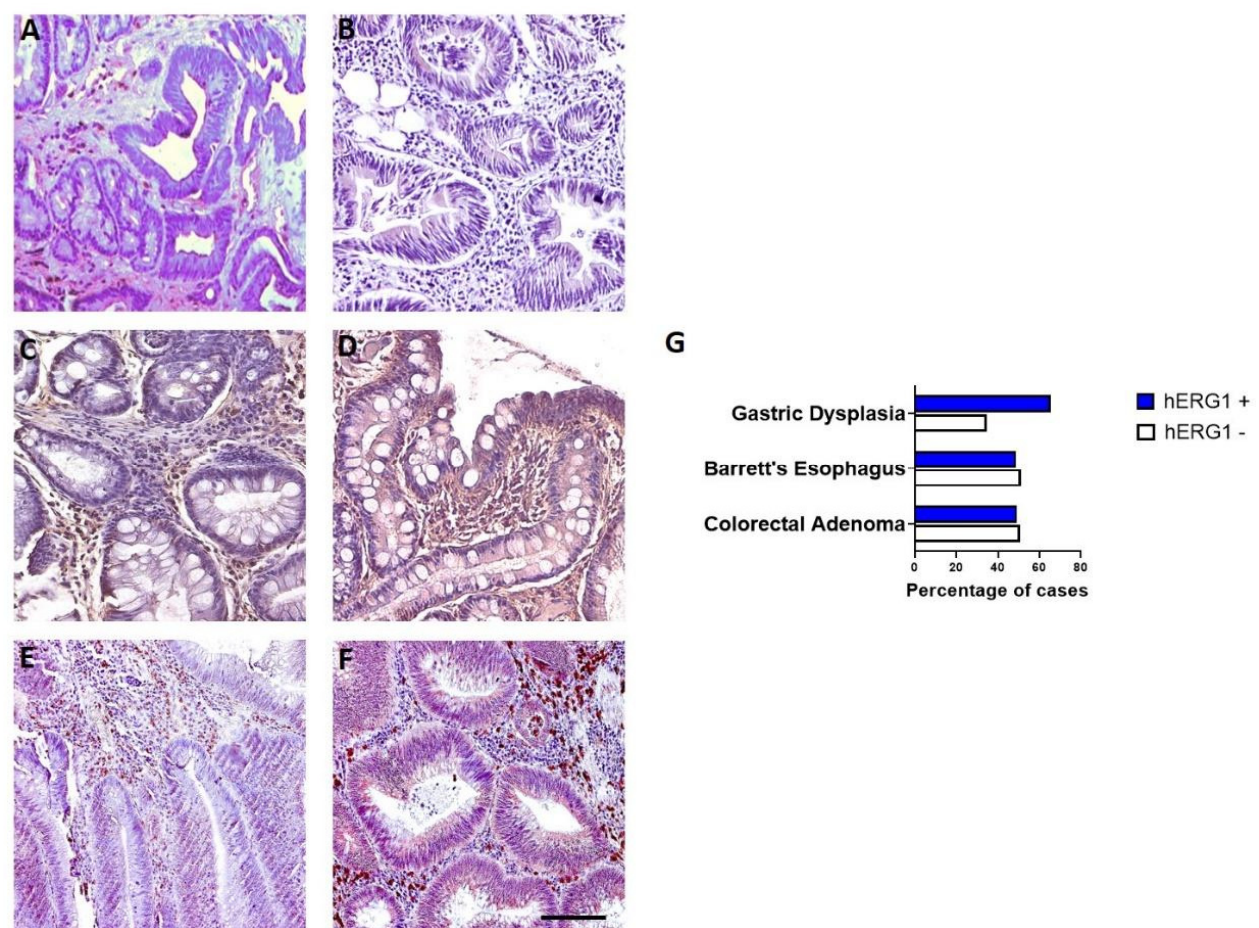
Figure 2. hERG1 potassium channel expression in preneoplastic lesions of the GI tract. ( A , B ) Gastric dysplasia. ( C , D ) Barrett’s esophagus. ( E , F ) colorectal adenoma. Scale bar:100 μ m. ( G ) Histogram showing hERG1 expression in the three groups.